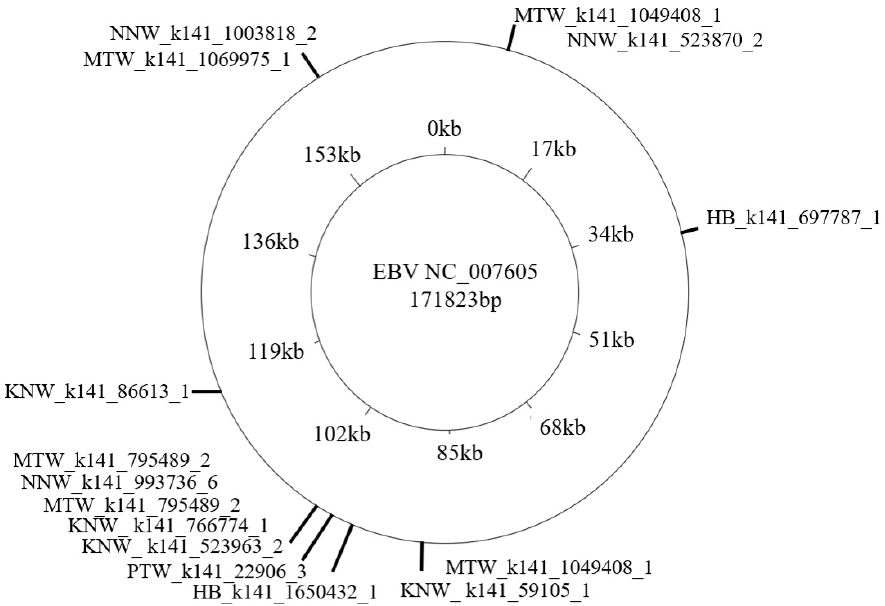
Figure 2. The examples sequence location of EBV from blood and water on EBV RefSeq NC_007605 (171,823 bp complete genome) when using cutoff >50 bp. EBV were mostly found at the location about 800 kb–102 kb. Key: HB, pooled human blood samples; MTW, tap water from Mae Ka (No. 1);